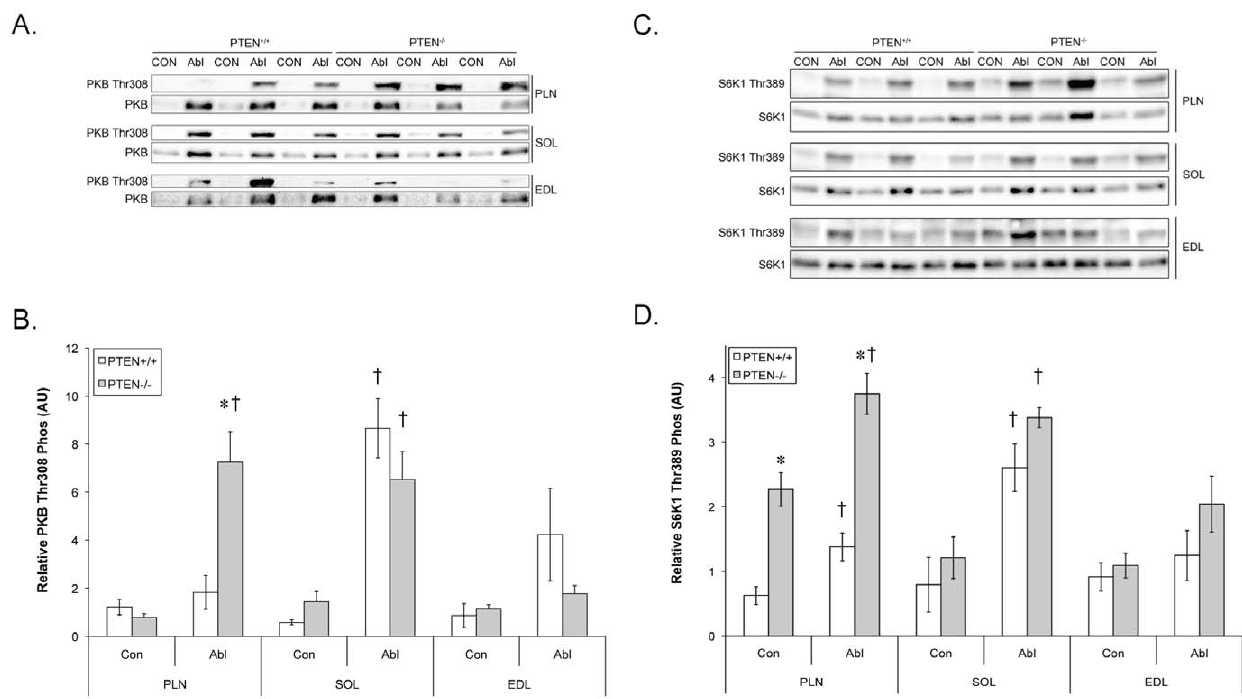
Figure 5. Muscle specific PTEN knockout alters PKB and S6K1 signalling in select muscles. The phosphorylation of PKB and S6K1 were determined in control muscles and muscles following overload of the plantaris (PLN) and soleus (SOL) muscles, by ablation of the gastrocnemius muscle for 10 days or the extensor digitorum longus (EDL) muscle by removal of the tibialis anterior muscle for 4 weeks. (A) Phosphorylation of PKB at Thr308 and its (B) quantification as well as (C) the phosphorylation of S6K1 at Thr389 and (D) its quantification. Data presented are mean 6 SEM for n=6 animals. * indicates significantly different than the wild type and { indicates significantly different than control.